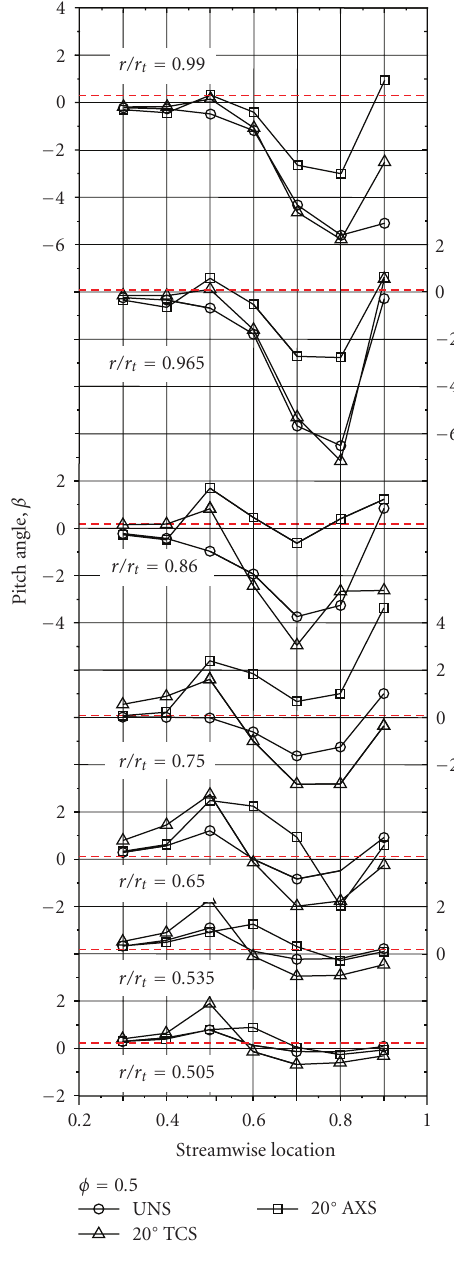
Figure 9: Pitch angle